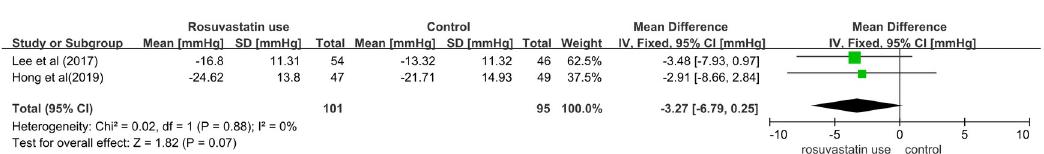
Fig 7. Pooled mean differences for the outcomes of systolic blood pressure changes in patients with hypertension treated with a combination of rosuvastatin and one antihypertensive agent.